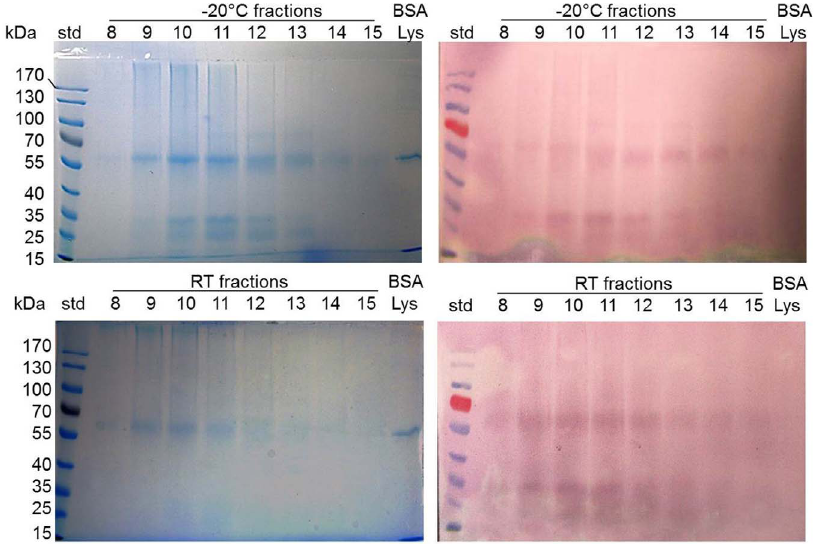
Figure 5. Enhaced quinone binding by the 31 kDa honey protein. Quinone-containing proteins in SEC fractions of honey stored at 2 20 u C and at room temp representing Coomassie blue-stained proteins of the master SDS gel and (left panel) corresponding blot of NBT-positive proteins (right panel). BSA and lysozyme were used as a control.